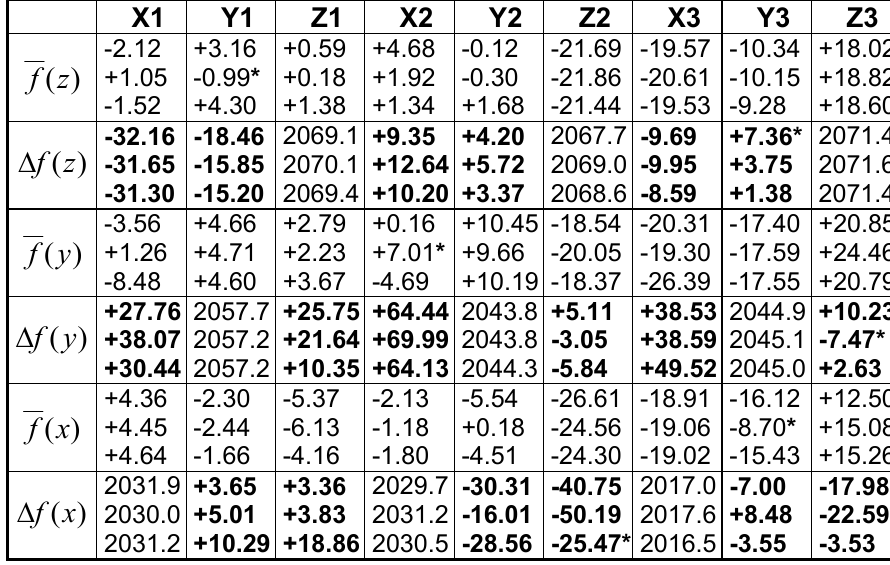
Table 1 – Experimental results on three different surfaces Таблица 1 – Экспериментальные результаты по трем различным поверхностям Табела 1 – Резултати експеримената на три различите